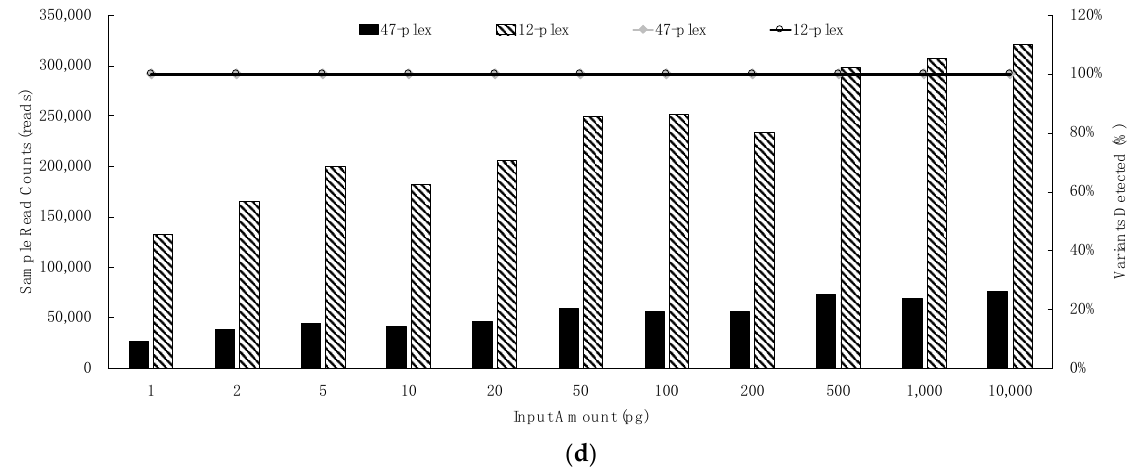
Figure 3. Sensitivity studies of the control region and mtGenome multiplexes: DNA inputs, library purification and normalization methods, sample plexity. Various gDNA template inputs ( x -axis) relative to total reads per sample ( y -axis, left), and relative to detection of expected variants detected under a set of condition(s) ( y -axis, right) plotted as open and closed circles shown in horizontal one atop each graph. ( a ) control region multiplex: dilution series of gDNAs HG01204 (solid bars, closed circle) and NA18524 (hatched bars, open circle). Libraries were prepared in duplicate, purified 1 × and normalized with BBN (average of two reps plotted), ( b ) control region multiplex: dilution series of gDNAs HG01204 (solid bars, closed circle) and NA18524 (hatched bars, open circle). Libraries were prepared in duplicate, purified 2 × and normalized with QN (average of two reps plotted), ( c ) mtGenome multiplex: dilution series of HL60 gDNA. Libraries were prepared in duplicate, purified 1 × , normalized with BBN (solid bars, closed circle), or purified 2 × and normalized with QN (hatched bars, open circle) (average of two reps plotted), ( d ) control region multiplex: dilution series of HL60 gDNA. DNA libraries were prepared in quadruplicate with three negative amplification controls, purified 1x and normalized with QN. MiSeq FGx runs using micro sequencing kit were conducted with either 12 or 47 sample plexity, shown as solid or hatched bars, respectively, ( e ) mtGenome multiplex: dilution series of HL60 gDNA. Libraries were prepared in duplicate, purified 2 × and normalized with QN. MiSeq FGx runs using standard sequencing kit were conducted with either 8 or 16 sample plexity, shown as solid or hatched bars,